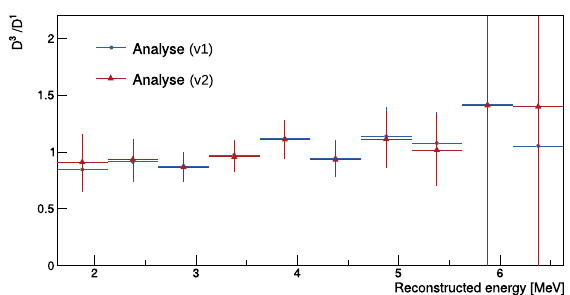
Figure 6. Comparison of the IBD energy spectrum ratios between cell 3 and cell 1 when using single events as reference for the fit of the electronic component (v1) or the deviation from single events (v2) (see text). The IBD energy spectrum in v1 analysis was obtained with a two-Gaussians model to fit the IBD-like background whereas the three-Gaussians model is used in v2 analysis.